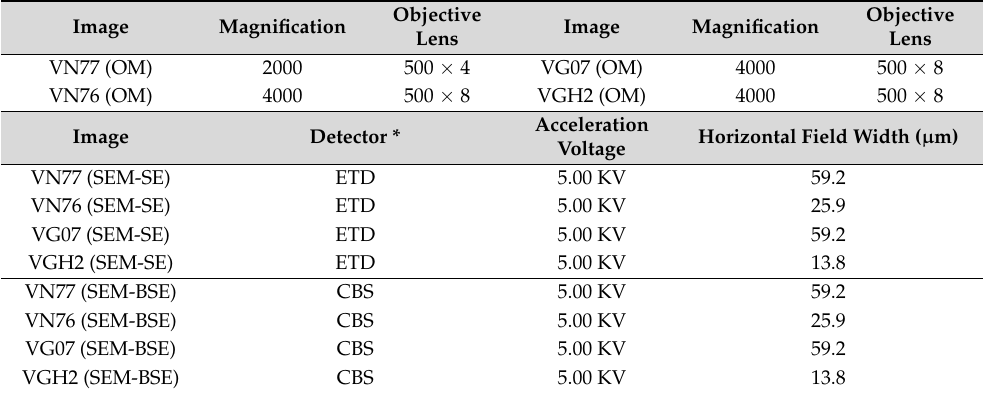
Figure 3. Microstructural images of the cemented carbide grades studied, obtained by: optical microscope (OM), i.e., laser scanning microscope in laser mode; scanning electron microscope with secondary electrons (SEM-SE); and SEM with backscattered electrons (SEM-BSE). Table 6. Configurations of the implemented microscopes in Figure